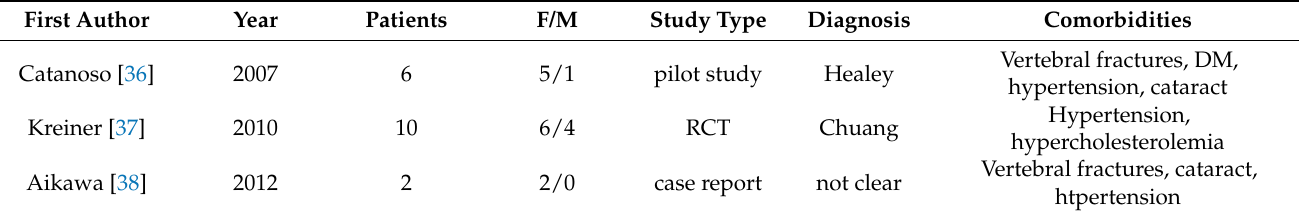
Table 3. Etanercept in patients with PMR: main features of the three discussed studies.